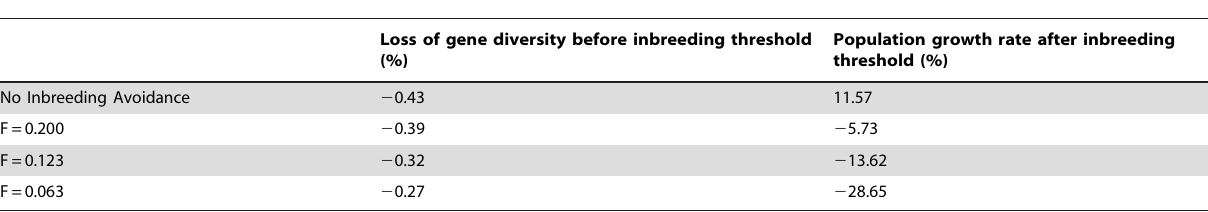
Table 3. Average percent gene diversity lost annually before inbreeding thresholds were reached and population growth rates after thresholds began influencing mate availability in simulated African wild dog populations experiencing a range of levels of inbreeding